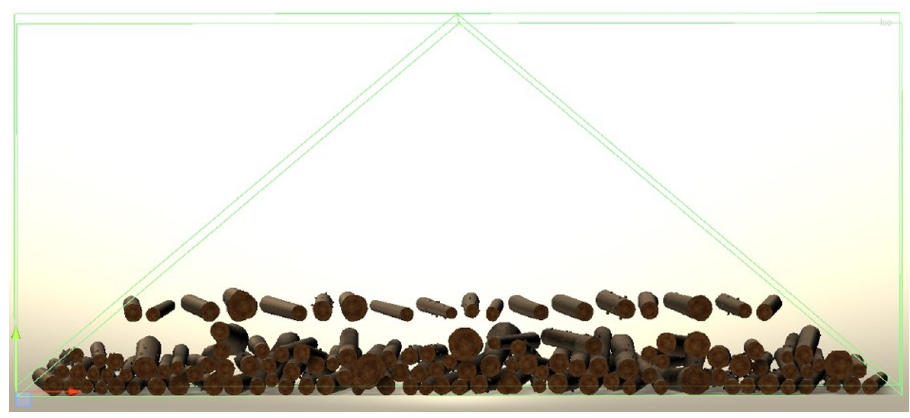
Fig 5. Virtual stacking